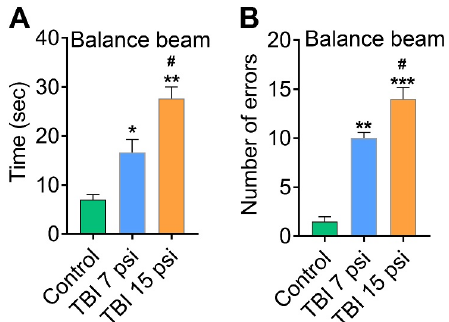
Figure 4. Balance beam test: ( A,B ). Balance beam test was performed on the same animals and both 7 and 15 psi injured mice displayed more time spent ( A ) in the balance beam with more number of errors ( B ) than control mice. Values are mean ± SEM; n = 6. * p < 0.05, ** p < 0.01, *** p < 0.001 versus uninjured control; # p < 0.05 versus 7 psi injury.